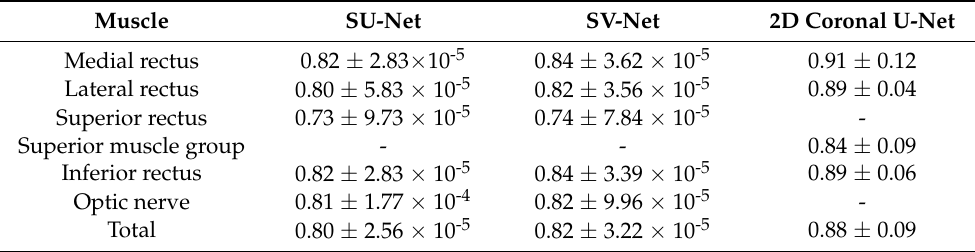
Table 7. Regional IOU score of our model and previously published CNN models for extraocular muscle segmentation on CT. Values indicate mean IOU ± standard deviation. SU-Net and SV-net proposed by Zhu et al. [12] was trained and evaluated using images from 97 subjects without contrast enhancement and our model was trained and evaluated using images from 210 subjects with contrast enhancement.